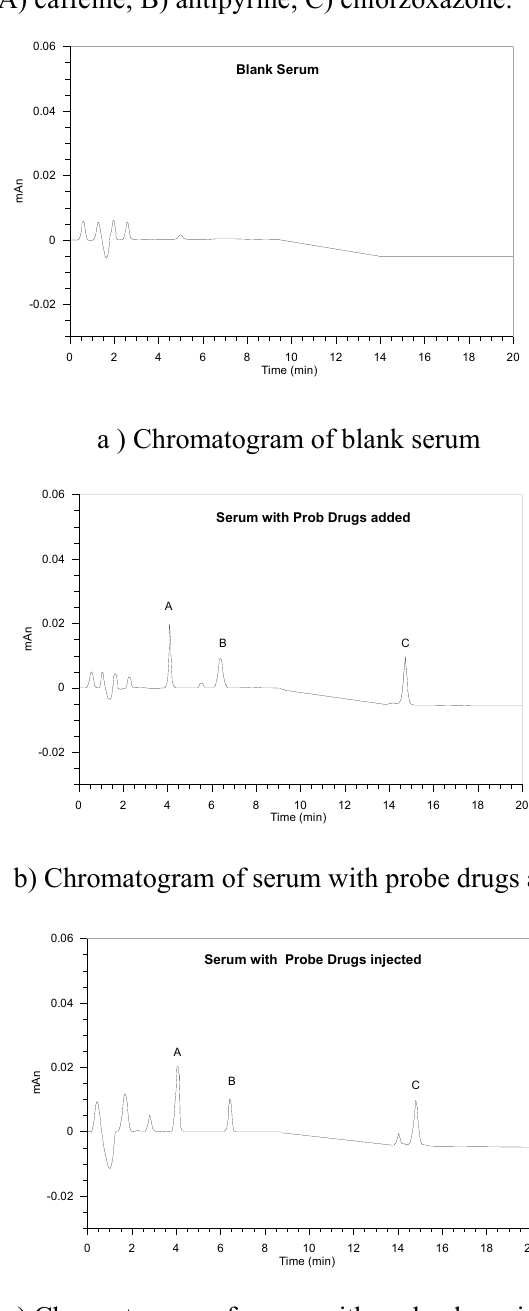
Figure 2 . Chromatograms of probe drugs in different